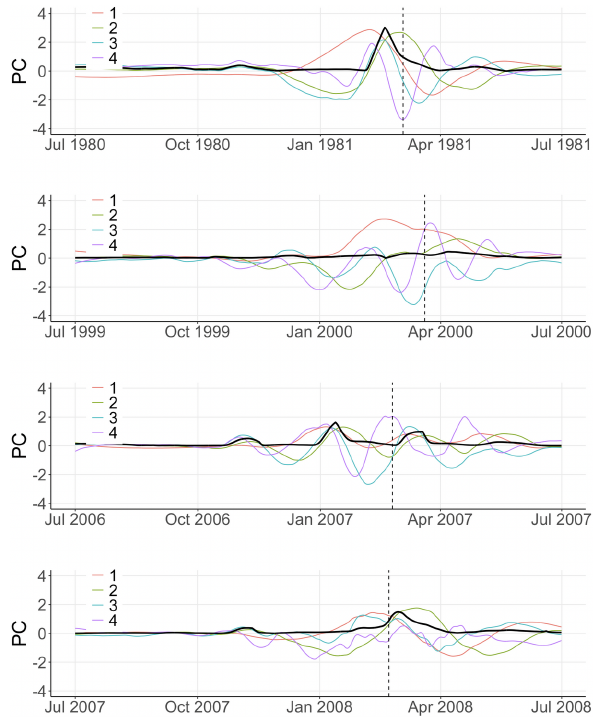
Figure A1. First four principal components for winters 1980/99, 1999/2000, 2006/07, and 2007/08 obtained using PCA on polar- cap-averaged temperature anomalies at pressure levels 150, 125, 100, 70, 50, 30, 20, 10, 7, 5, 2, and 1hPa with a temporal embed- ding of T = 2 months. Vertical dashed line: central date of the 2009 SSW. Solid black line: SSW index I over the same period defined as a function of the second and third principal components as in Eq.